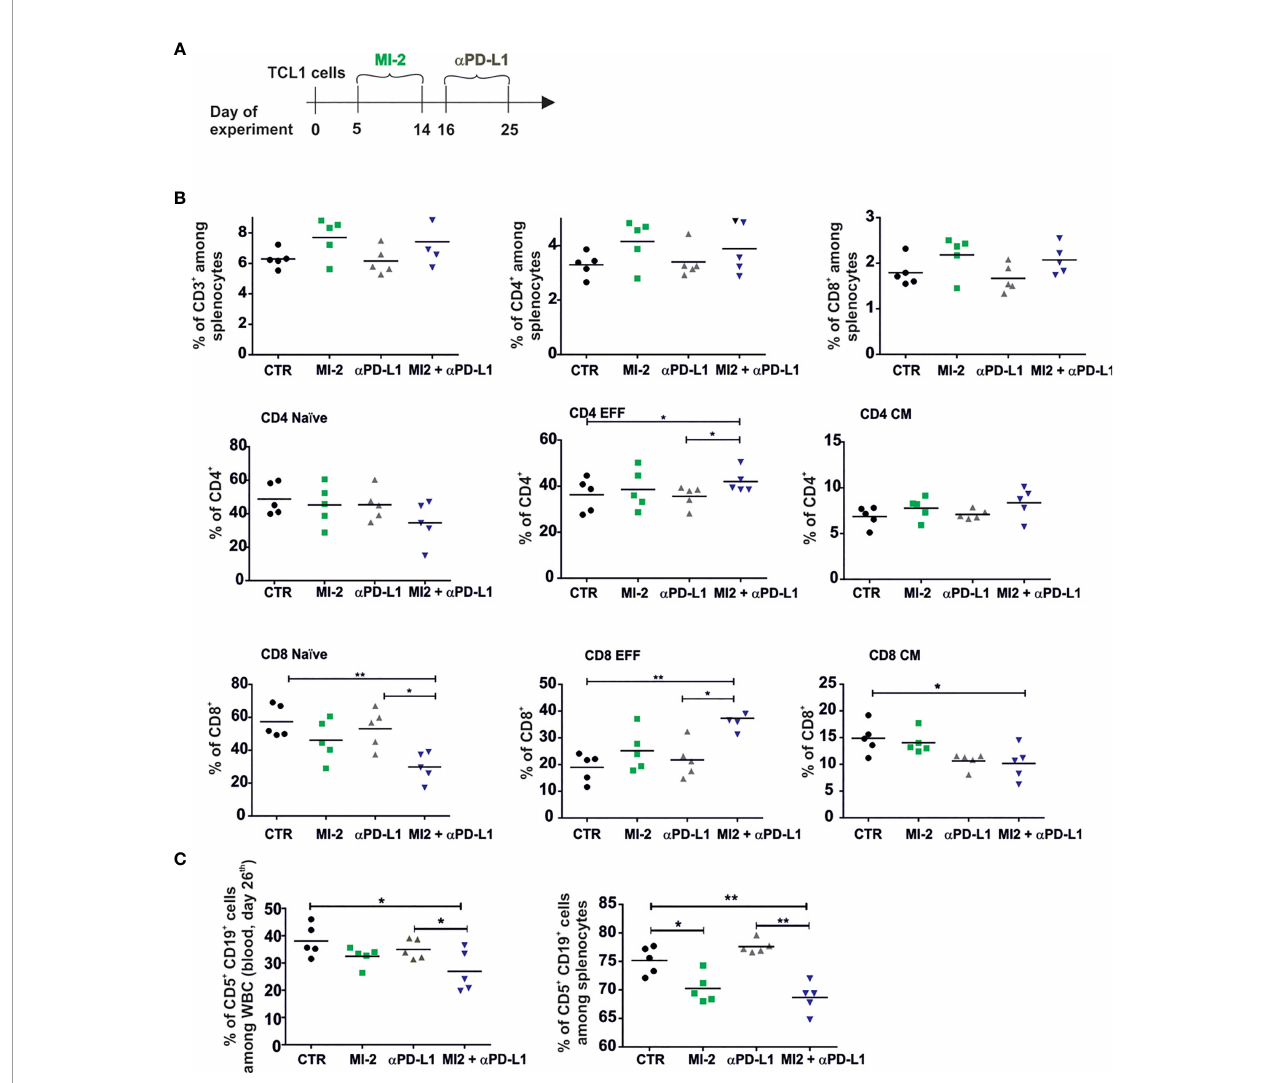
FIGURE 6 | The pretreatment with MALT-1 inhibitor sensitizes leukemia to the therapy with anti-PD-L1 at the advanced stage of the disease. (A) The graphs presenting a scheme of the experiment. (B) The percentage of CD3 + , CD4 + , CD8 + and naïve, effector (EFF), and central memory (CM) subpopulations of CD4 + and CD8 + . Cells were collected from spleens of untreated (CTR), MI-2 and/or aPD-L1-treated TCL1 leukemia-bearing mice, n = 4-5, each dot represents an individual sample (mouse), means, Mann-Whitney U test *p ≤ 0.05, **p ≤ 0.01. (C) The Percentage of leukemic cells (CD5 + CD19 + ) assessed by fl ow cytometry in blood (left panel) and spleens (right panel) at day 26th of the experiment, n = 5, each dot represents an individual sample (mouse), means, Mann-Whitney U test *p ≤ 0.05, **p ≤